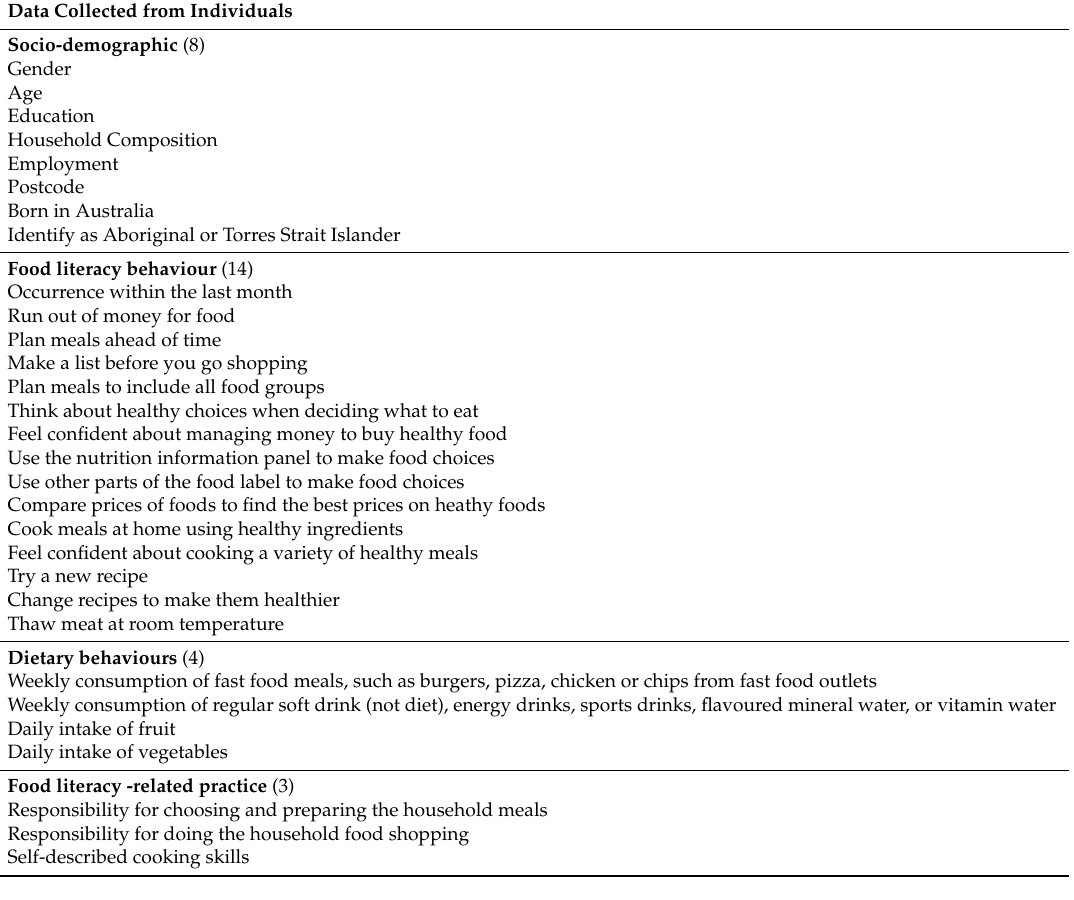
Table 1. Summary of data collected from individuals using the pre- program